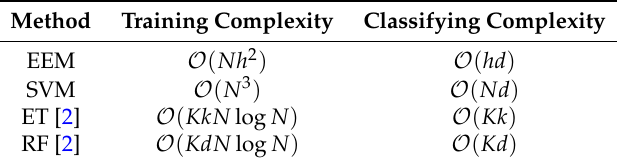
Table 3. Comparison of the computational complexity of all models. N is the number of training samples, d the number of features, h a predefined constant (much smaller than N ), K the number of trees in a forest and k a predefined constant (much smaller than d